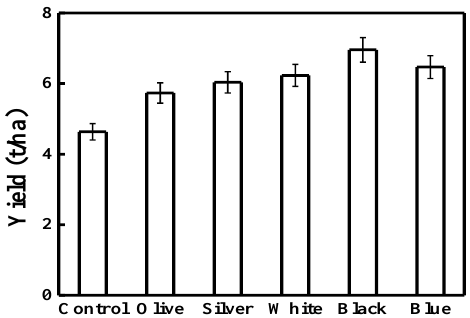
Fig. 3. Effects of different types of plastic films on yield in lettuce. Each histogram represents a mean value of three independent experiments and the vertical bars indicate SE (n = 3)